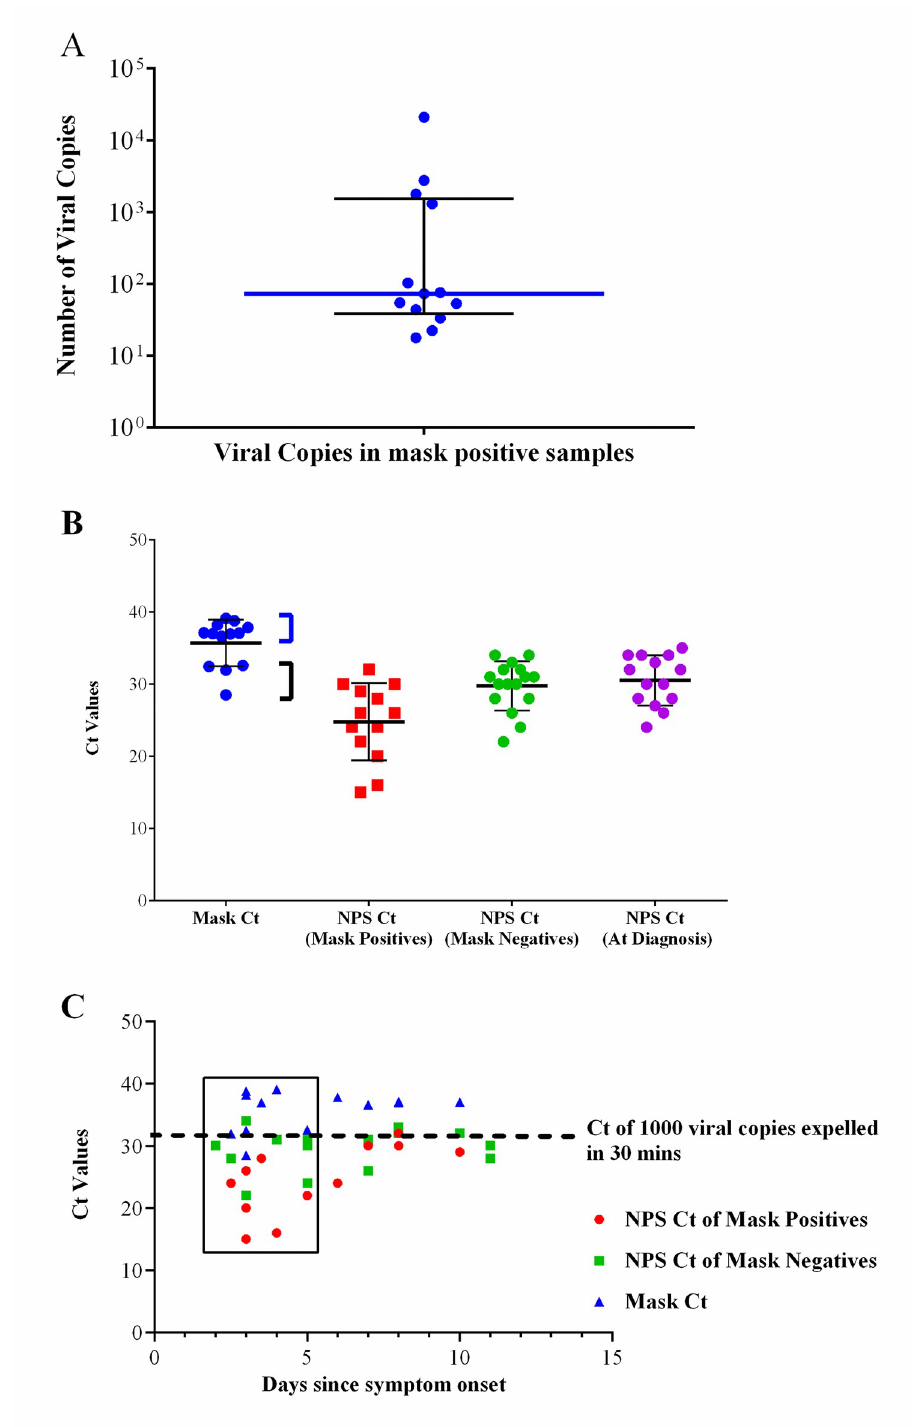
Fig 1. Viral copies and Ct values in mask and NPS samples. (A) SARS-CoV-2 viral copies expelled in 30 minutes by the mask positive patients. Data represented as median with IQR with the blue line indicating the median viral copies. (B) The distribution of Ct values from mask and NPS samples. The Ct value of the E gene in mask samples (blue) at sampling, the Ct value of the N gene in mask positive samples (red) and mask negative samples (green) at sampling, and Ct value of the N gene in patient samples at diagnosis. The mask E gene Ct values showed two distinct groups of samples with low Ct values (black bracket) and samples with high Ct values (blue bracket). No distinct groups were